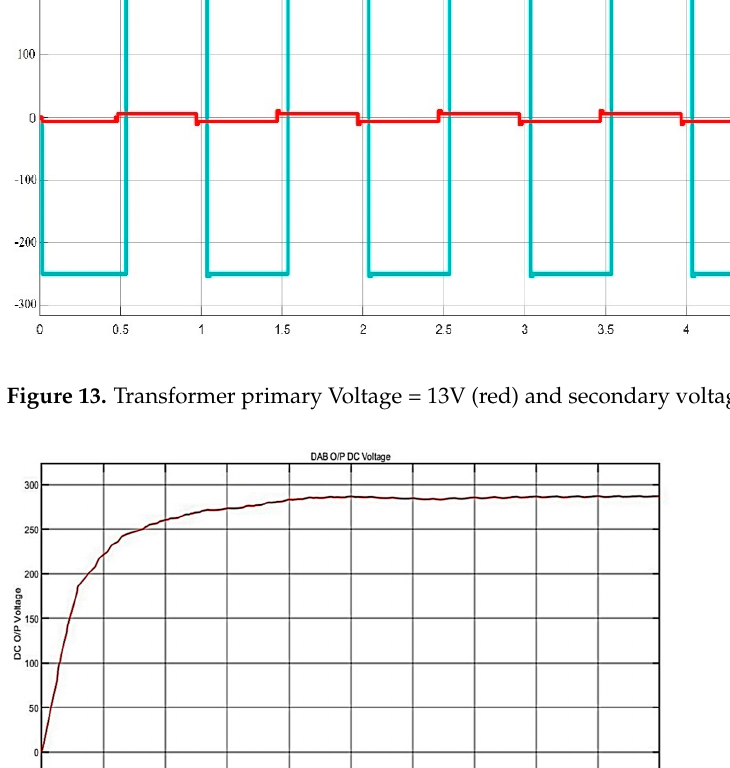
Figure 12. Dual active bridge-based boost inverter topology. Table 5. Proposed scheme parameters [10].